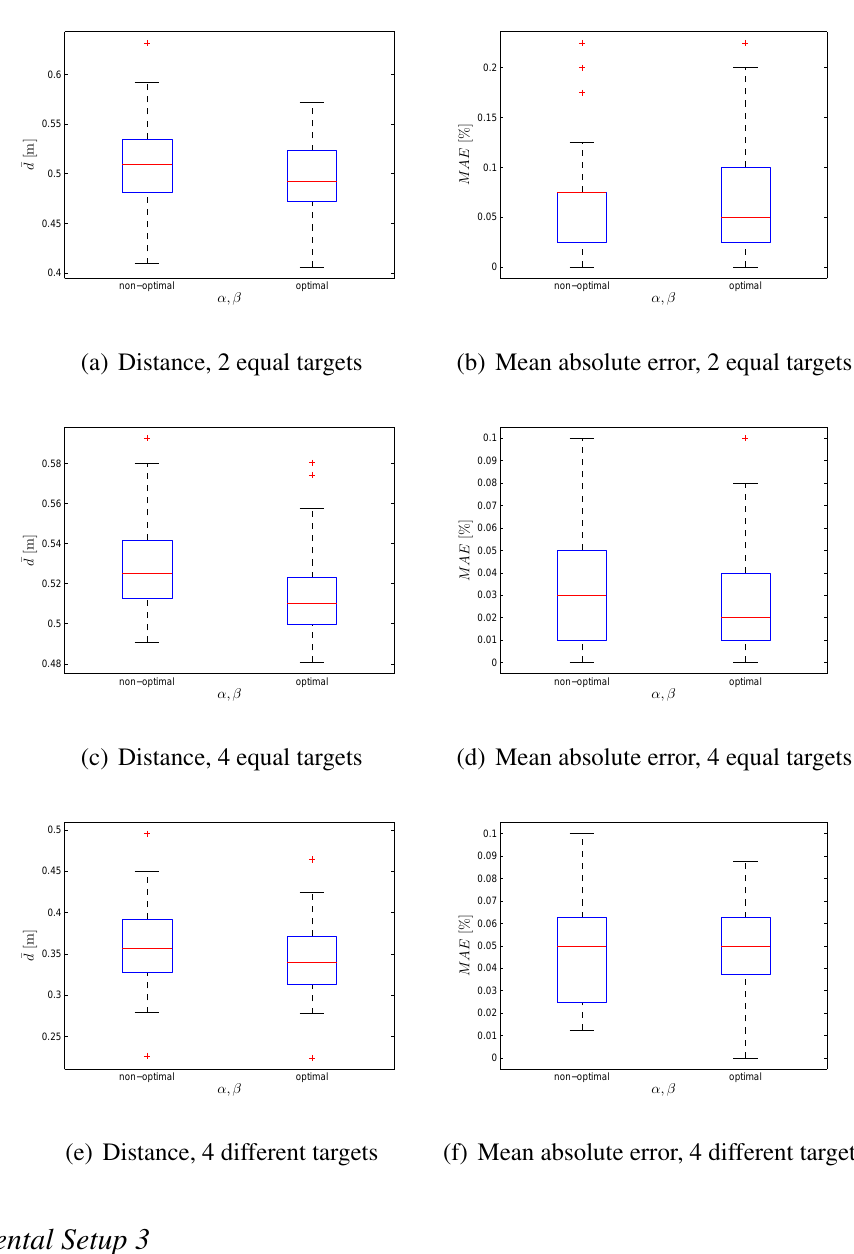
Figure 3. Box-plot comparison of average distance and MAE for 40 robots; (cid:11) = (cid:12) = 1 and (cid:11) = 2 : 65 ; (cid:12) = 2 : 55 . Each box-plot comprises observations ranging from the first to the third quartile. The median is indicated by a horizontal bar, dividing the box into the upper and lower part. The whiskers extend to the farthest data points that are within 1.5 times the interquartile range. Outliers are shown with a plus symbol. The values were obtained from 50